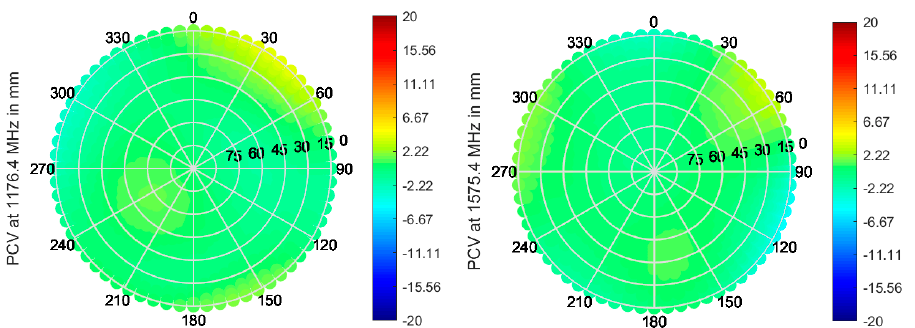
Figure 7. PCV in the upper hemisphere at L1/E1 ( left ) and L5/E5a ( right ) for the ANYWAVES GNSS All-Bands Antenna, with data provided by manufacturer.